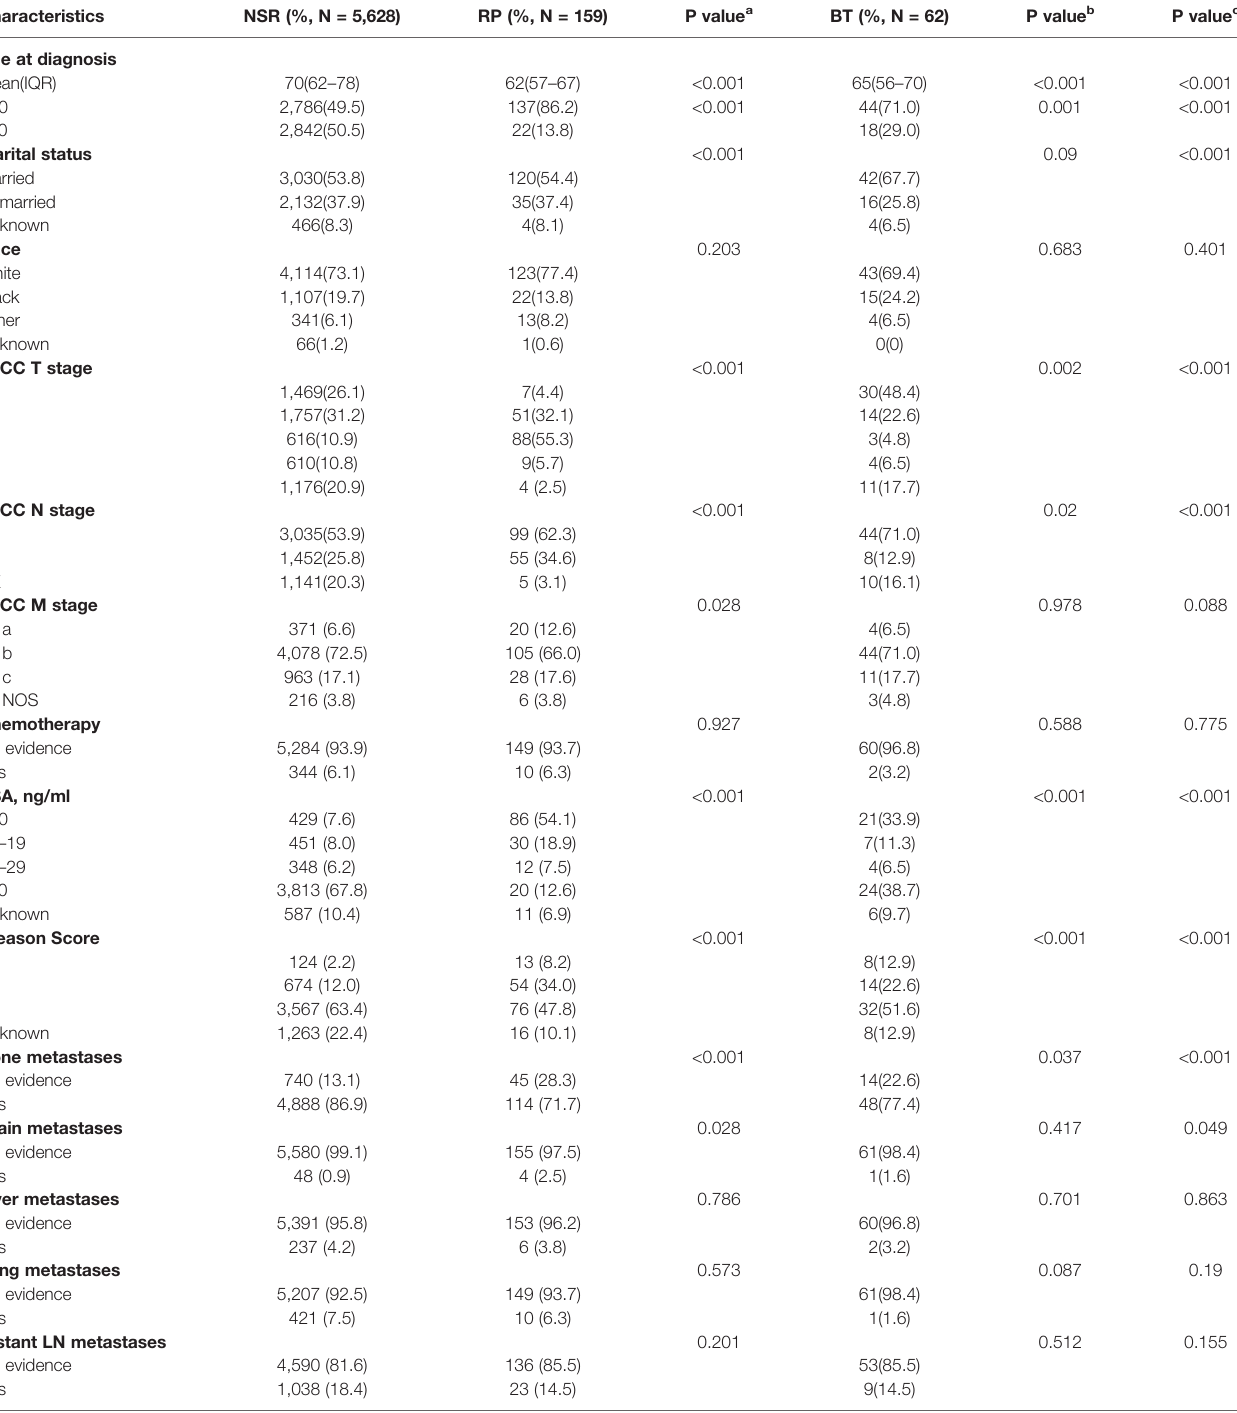
TABLE 1 | Baseline characteristics of metastatic prostate cancer patients in the SEER database.